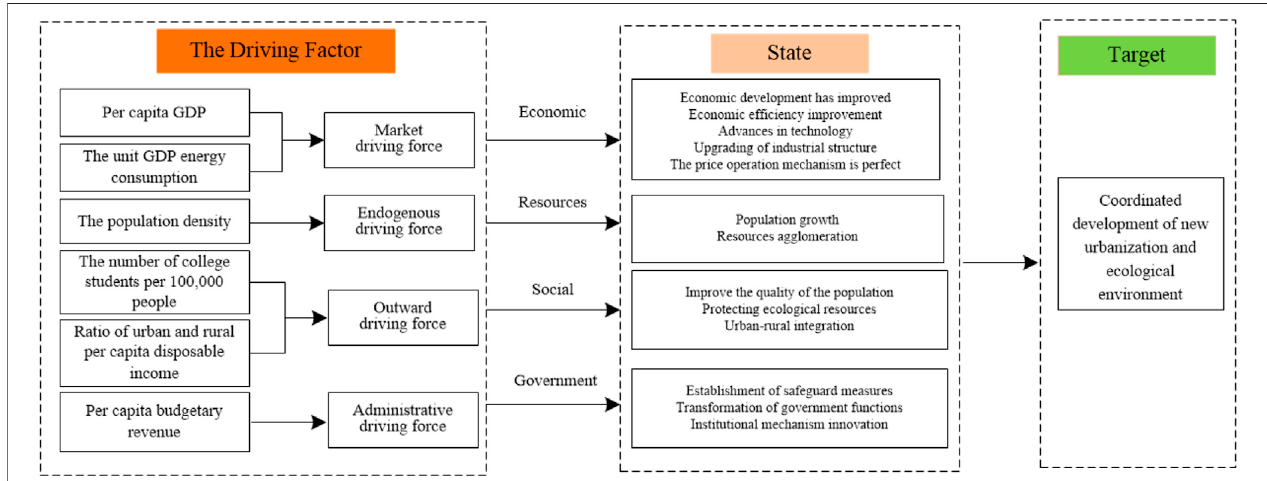
FIGURE 9 | The drive mechanism of system coordinated development between urbanization and